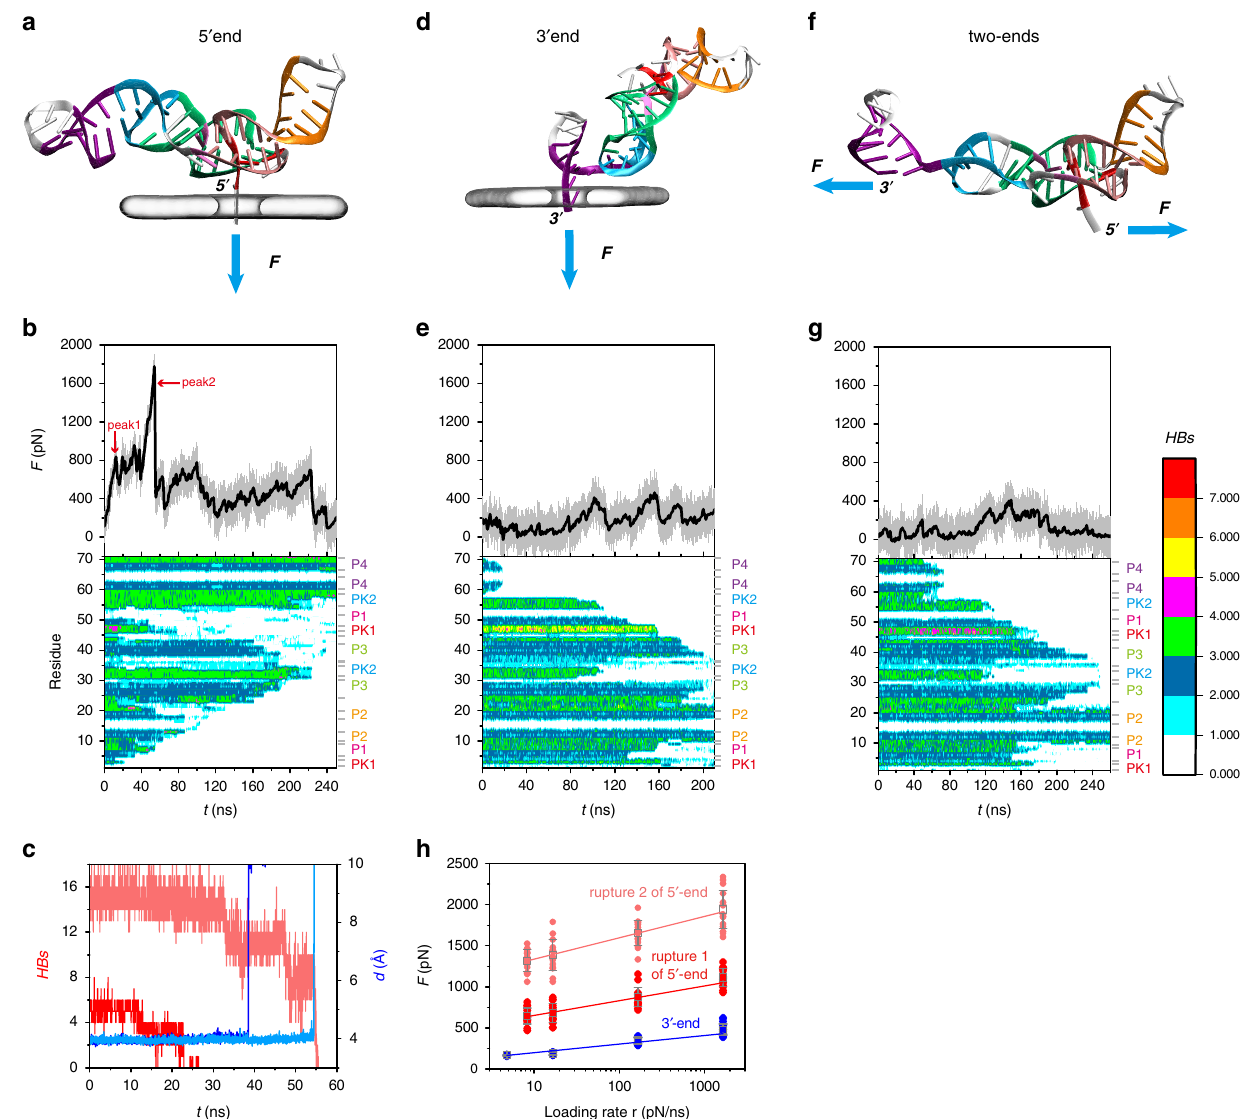
Fig. 6 SMD simulations for ZIKV xrRNA1. a , d , f Schematic illustraion of translocation from 5 ′ -end ( a ), 3 ′ -end ( d ) through the nanopore, and two-ends pulling ( f ). b , e , g Unfolding force pro fi les (top) and hydrogen bonds (HBs) for each residue (bottom) in xrRNA1 over the course of pulling at loading rate of 166.1 pN/ns ( r = κ · ν , pulling velocity ν and spring constant κ are 0.1 nm/ns and 1661 pN/nm, respectively) along 5-end ( b ), 3 ′ -end ( e ), and two-ends pulling direction ( g ). c Hydrogen bonds of 5 ′ -end structure (red) as well as P1 (pink), and sum of distance between Mg 2 + with two phosphorous oxygen consisting Mg 2 + -clamps (blue: C5-Mg 2 + -C23; sky blue: A6-Mg 2 + -C23) during initial unfolding along 5 ′ → 3 ′ direction. ( h ) Dependence of averaged rupture forces on loading rates for 5 ′ -end pulling of xrRNA1 and 3 ′ -end pulling of xrRNA1- Δ P4. The rupture forces and their mean with SD for each unfolding event at different loading rates are presented as point and box whisker, respectively. Source data for b , e , g , and h are provided as a Source Data fi